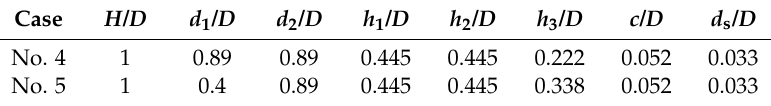
Table 2. Geometrical parameters of mixing systems with a dished bottom